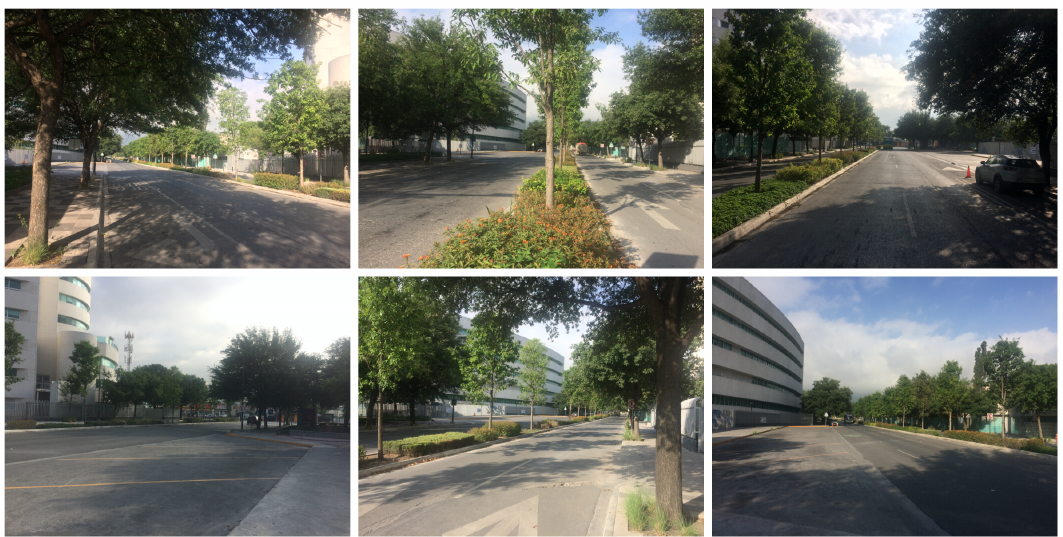
Figure 4. Real scenario collage of photos with considered scatterers as buildings, lamp posts, fences, and vegetation, among others.